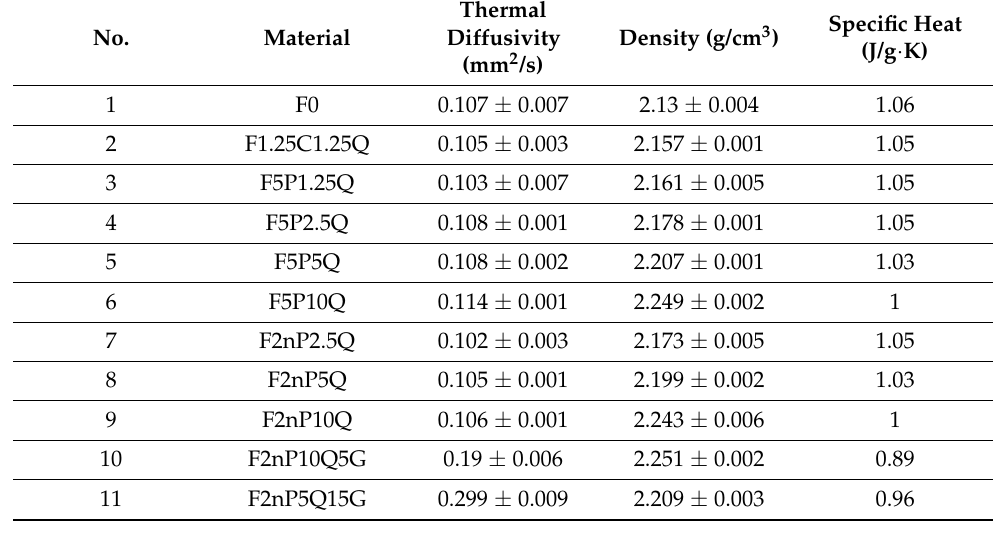
Table 2. Thermal properties of the unfilled FEP and FEP-based composites at 25 ◦ C.